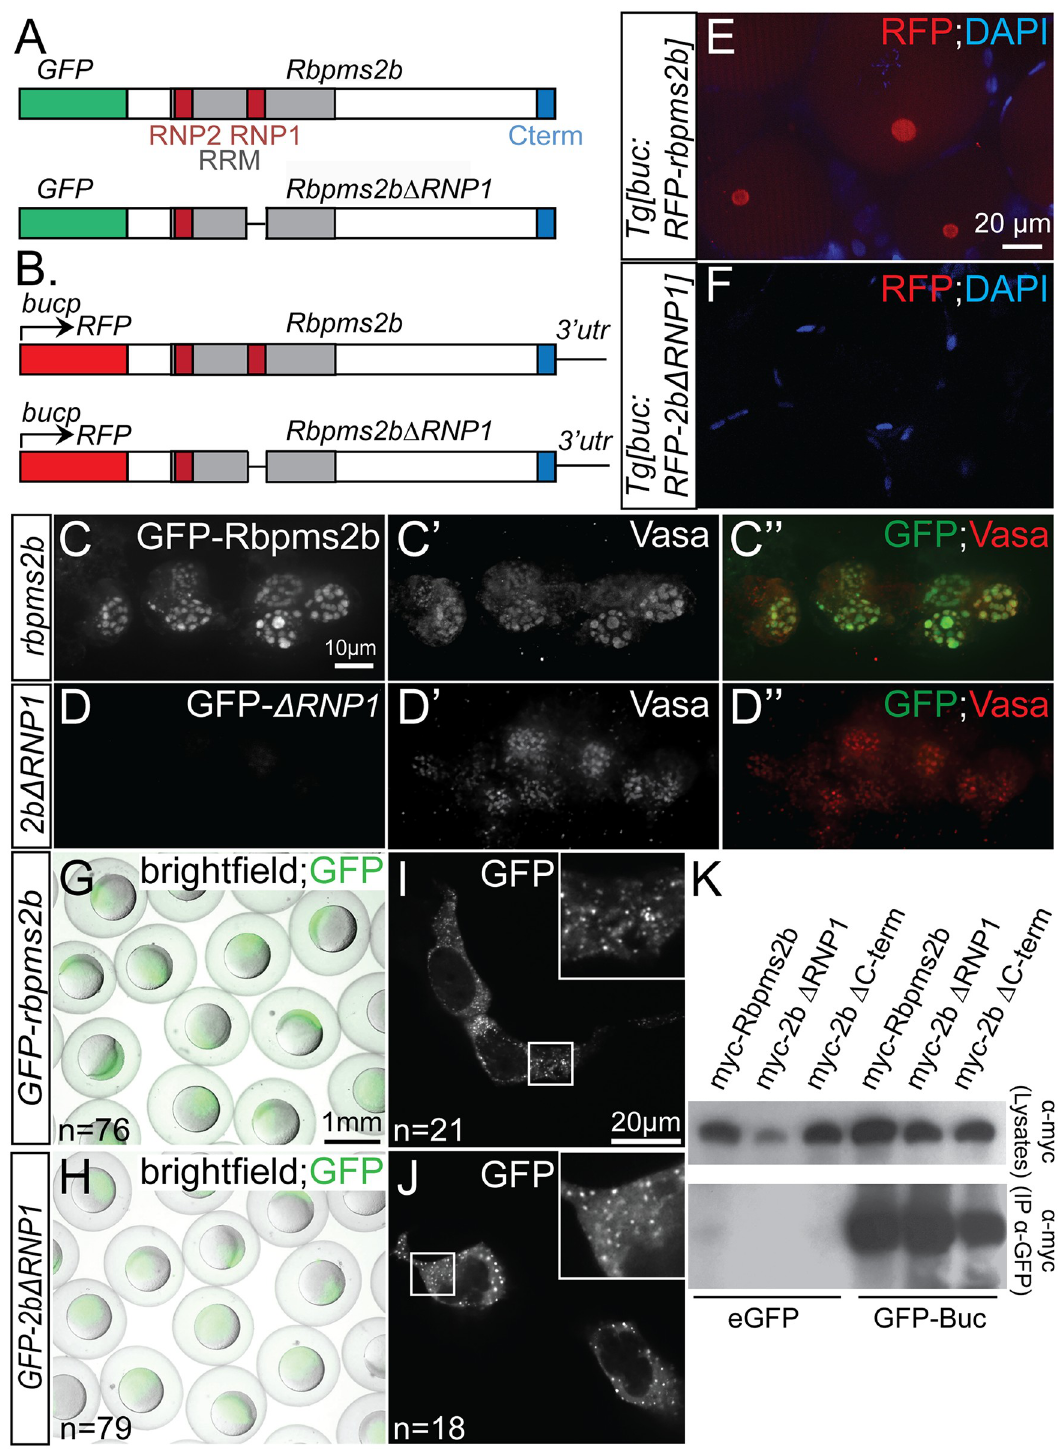
Fig 6. RNA-binding domain is required for Rbpms2 localization in germ cells. (A) Schematic representing constructs used in granule localization assays. (B) Schematic representing transgenic constructs used to express Rbpms2b in oocytes. (C-C”) Wild-type GFP-Rbpms2b localizes with Vasa in germ granules of PGCs. (D-D”) GFP-Rbpms2b Δ RNP1, a deletion of 7 residues within the RRM domain, does not localize to germ granules. (E-F) RFP-Rbpms2b expressed in transgenic Tg[buc:RFP-rbpms2b] ovaries localizes to the Bb (E), while RFP-Rbpms2b Δ RNP1 does not (F). (G-J) GFP-Rbpms2b and GFP-Rbpms2b Δ RNP1 are stably expressed in